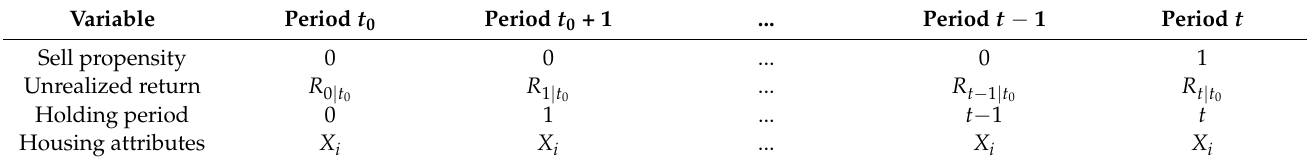
Table 4. Data derived